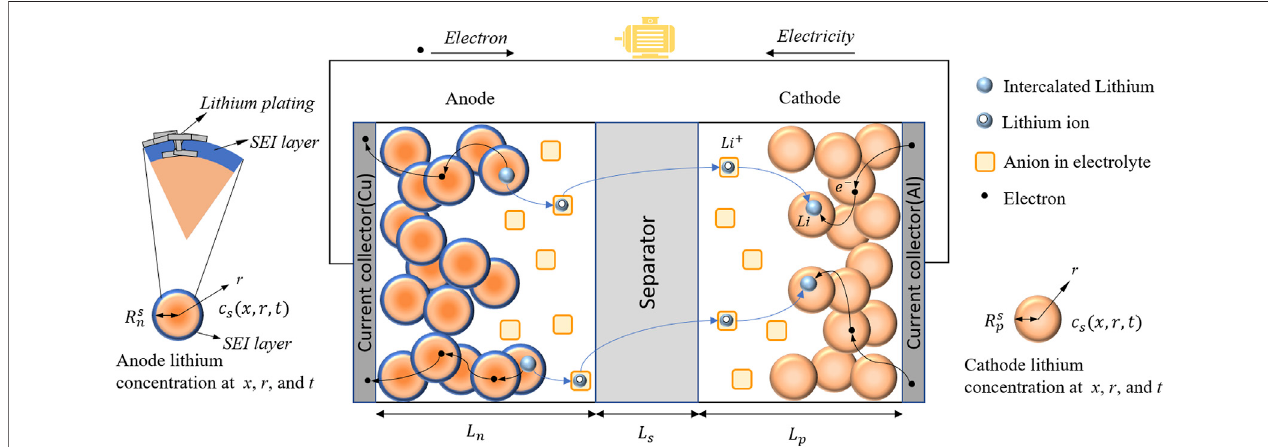
FIGURE 1 | Schematic diagram of the modi fi ed P2D model of lithium-ion